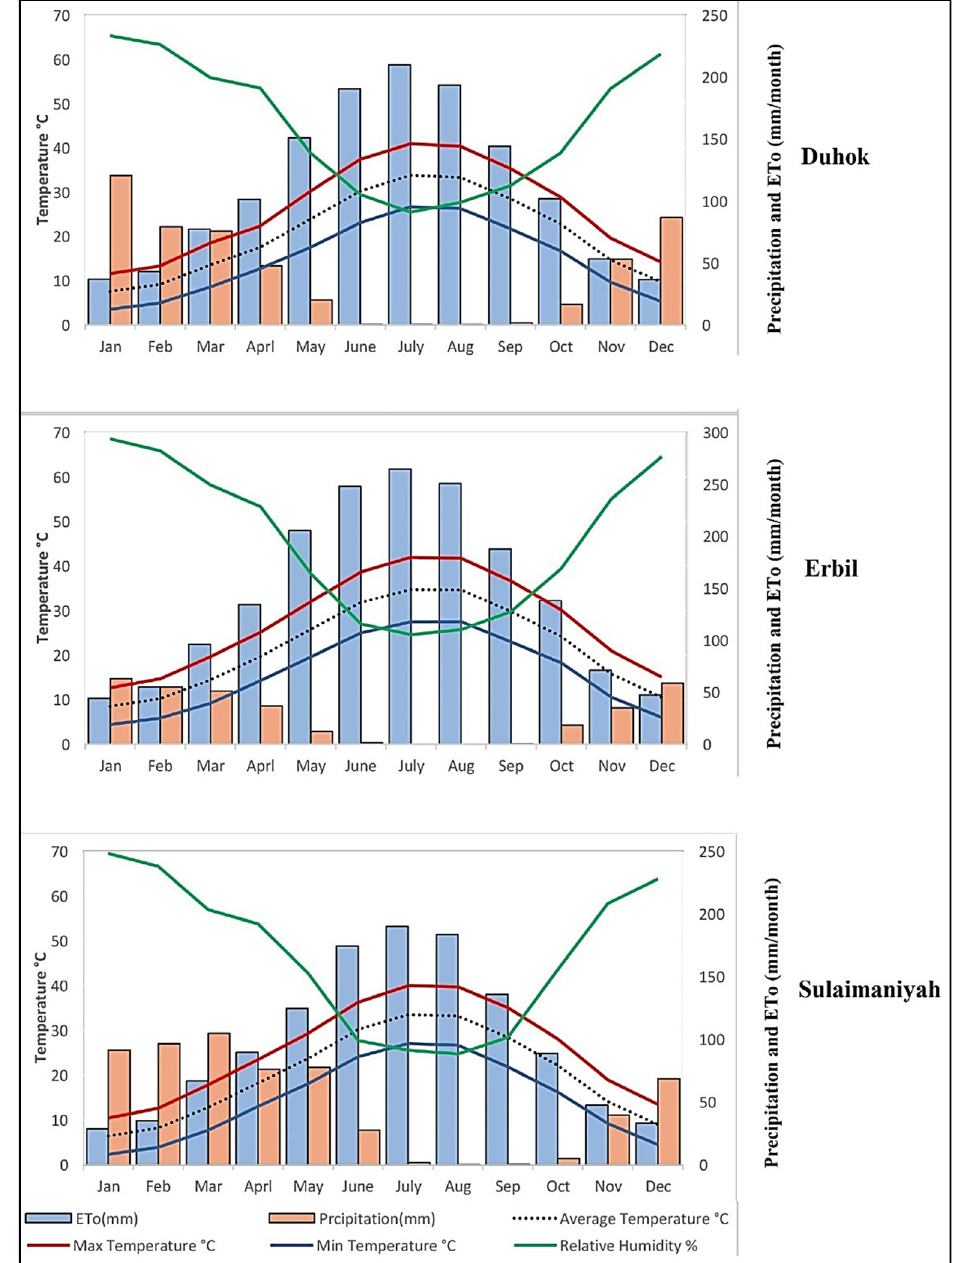
Figure 2. Monthly precipitation, relative humidity, potential evaporation, maximum, minimum, and mean temperature at Duhok (DU), Erbil (ER), Sulaimaniyah (SU), and surrounding areas recorded between 1998 and 2017.